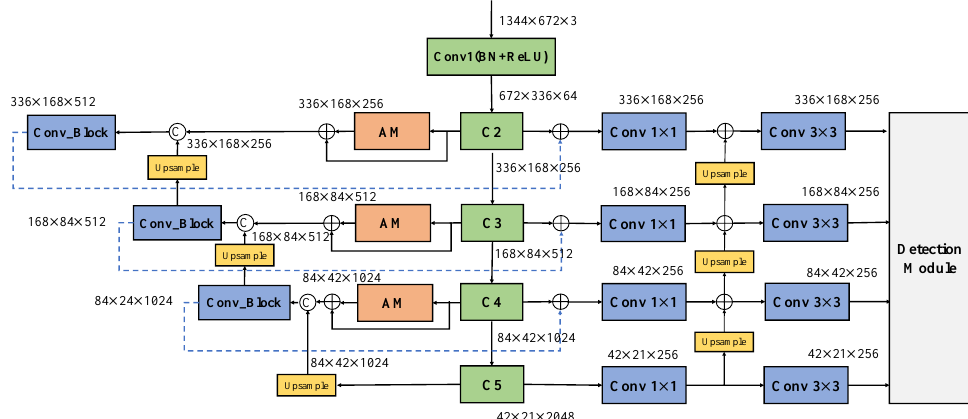
Figure 5. The parameters flow-chart of the novel fusion network. In the figure, the green blocks represent the feature extraction modules, the orange blocks represent the attention modules, the blue blocks represent the convolution blocks, the yellow blocks represent the upsampling, the grey block represents the detection module, © is for cascade, and ⊕ is element-wise